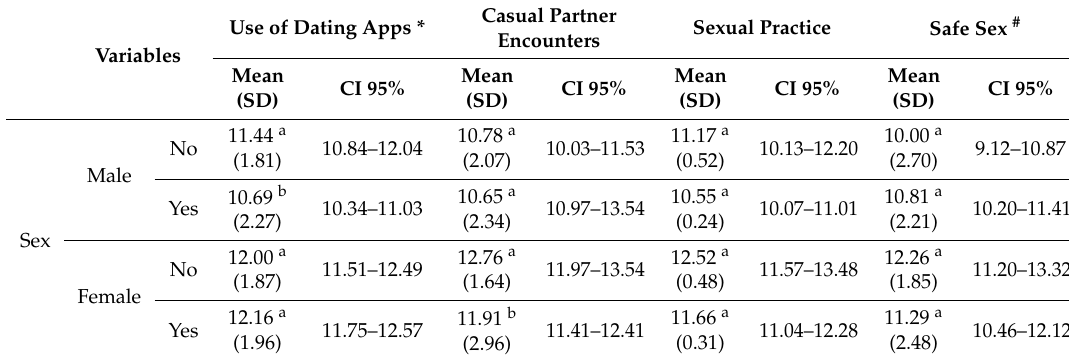
Table 3. Analysis of attitude toward sexual health and use of dating applications, casual partner encounter, sex practice, and safe